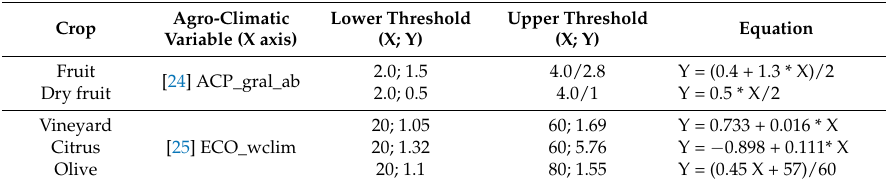
Table 4. Ramp functions construction and